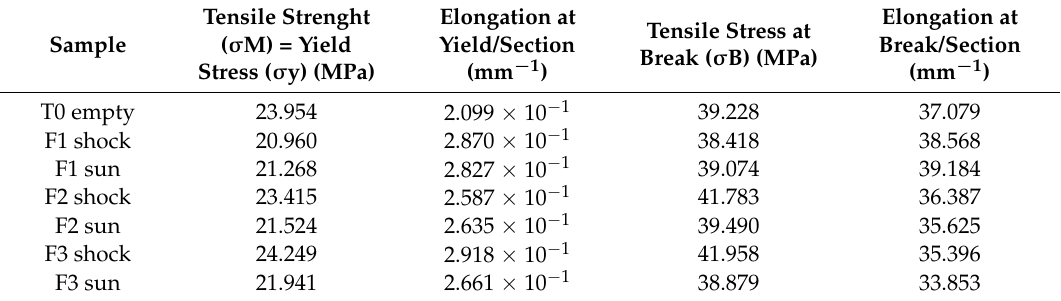
Table 4. Tensile test mean data obtained for packaging.